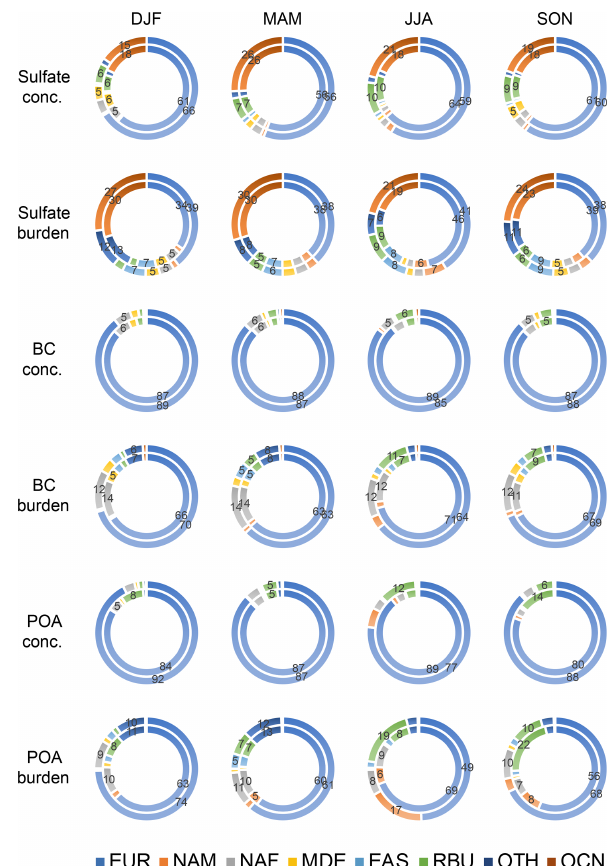
Figure 6. Relative contributions (in percent) by emissions from ma- jor tagged source regions to near-surface concentrations (conc.) and column burdens of December–January–February (DJF), March– April–May (MAM), June–July–August (JJA), and September– October–November (SON) mean sulfate, BC, and POA over Eu- rope; averaged over 2010–2018. Outer rings represent the modeled values, and the relative contributions in inner rings are calculated based on absolute values normalized by the ratio of seasonal emis- sion to annual mean. Values larger than 5% are